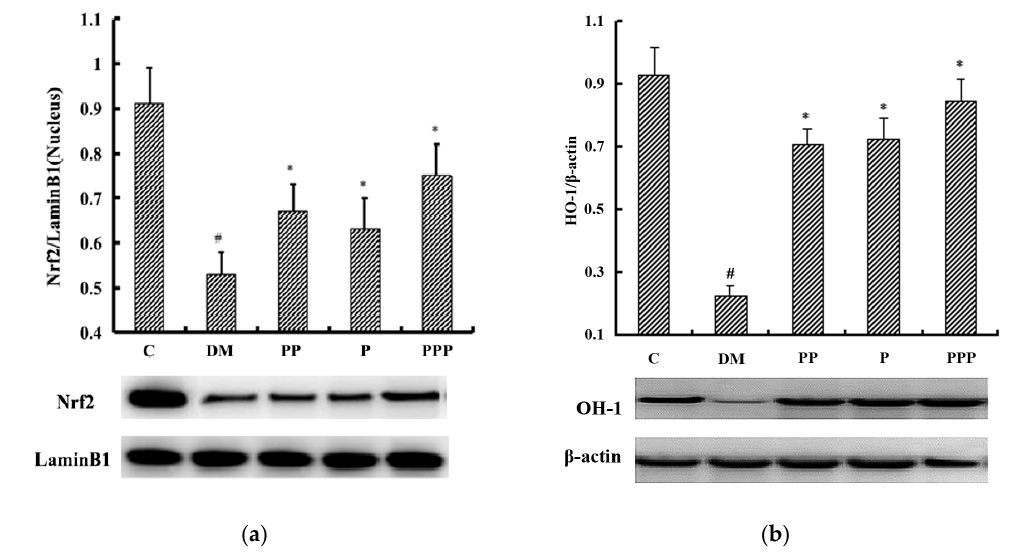
Figure 7. A Western blot analysis of the proteins that are associated with the Nrf2/HO-1 pathway ( n = 10). ( a ) A relative density analysis of Nrf2 in the nucleus. ( b ) A relative density analysis of HO-1. The relative density of the Nrf2 and HO-1 protein bands is expressed as a ratio (Nrf2/Lamin B1, HO-1/ β -actin). # p < 0.05 compared with the C group; * p < 0.05 compared with the DM group.